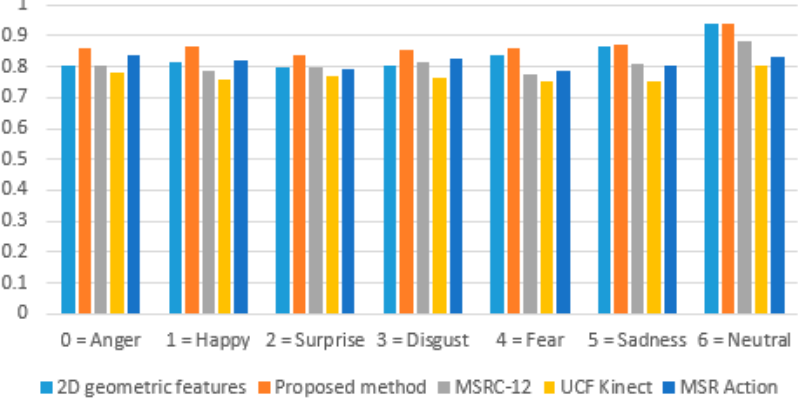
Figure 7. Comparison of F-score for multimodal emotion recognition.